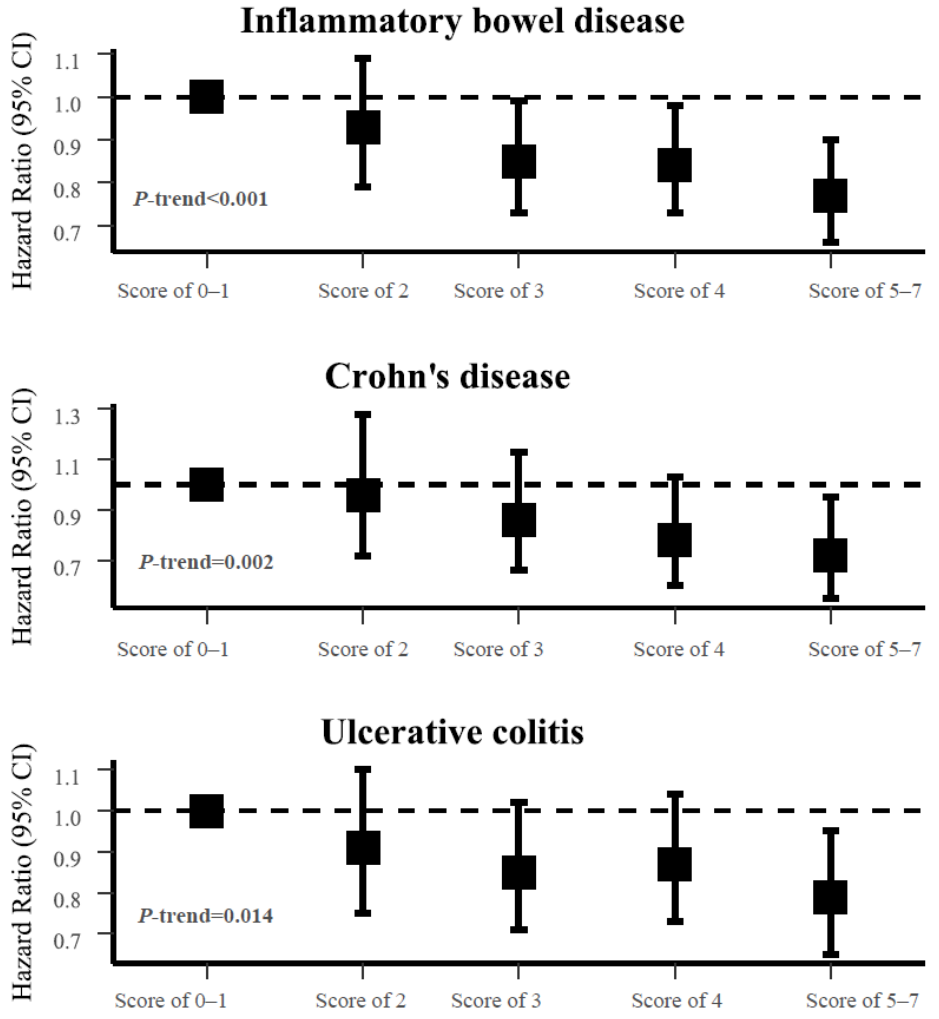
Figure 2. Associations between cardioprotective diet scores and risk of inflammatory bowel disease, Crohn’s disease, and ulcerative colitis. HRs and 95% CIs were calculated using the Cox model adjusted for sex, age, age squared, ethnicity, education, TDI, physical activity, smoking status, alcohol drinking status, and BMI. Abbreviations: CI, confidence interval; HR, hazard ratio; BMI, body mass index; TDI, Townsend deprivation index.